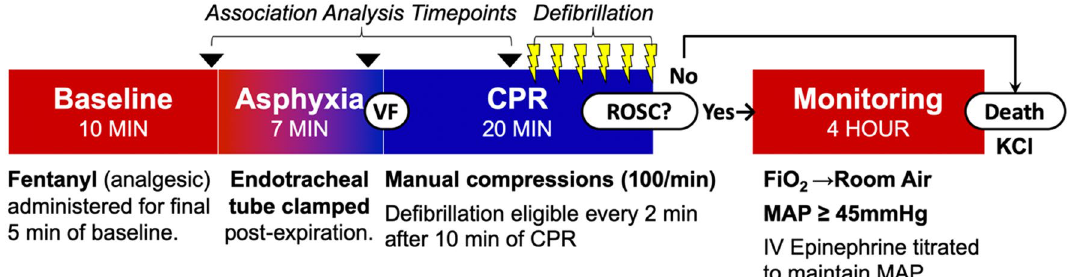
Figure 1. Experimental Protocol: Continuous non-invasive frequency-domain diffuse optical spectroscopy (FD-DOS) measurements of cerebral hemodynamics were continuously acquired from start of Baseline, through Asphyxia, CPR, and four-hours post-Return of Spontaneous Circulation (ROSC). The association between cerebral hemodynamics and ROSC were examined at baseline, the end of asphyxia, and in the 10th minute of CPR prior to the first defibrillation. VF, ventricular fibrillation; BPM, beats per minute; FiO 2 , fraction of inspired oxygen; MAP, mean arterial pressure; KCl, potassium